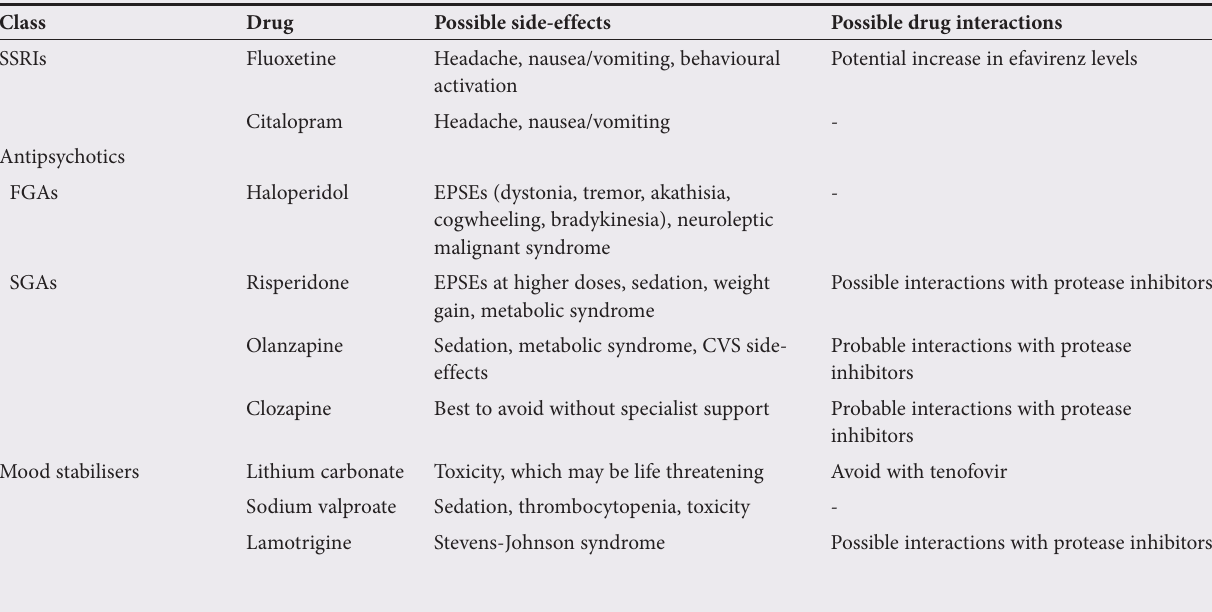
Table 7. Commonly used psychotropic medications and their interactions *